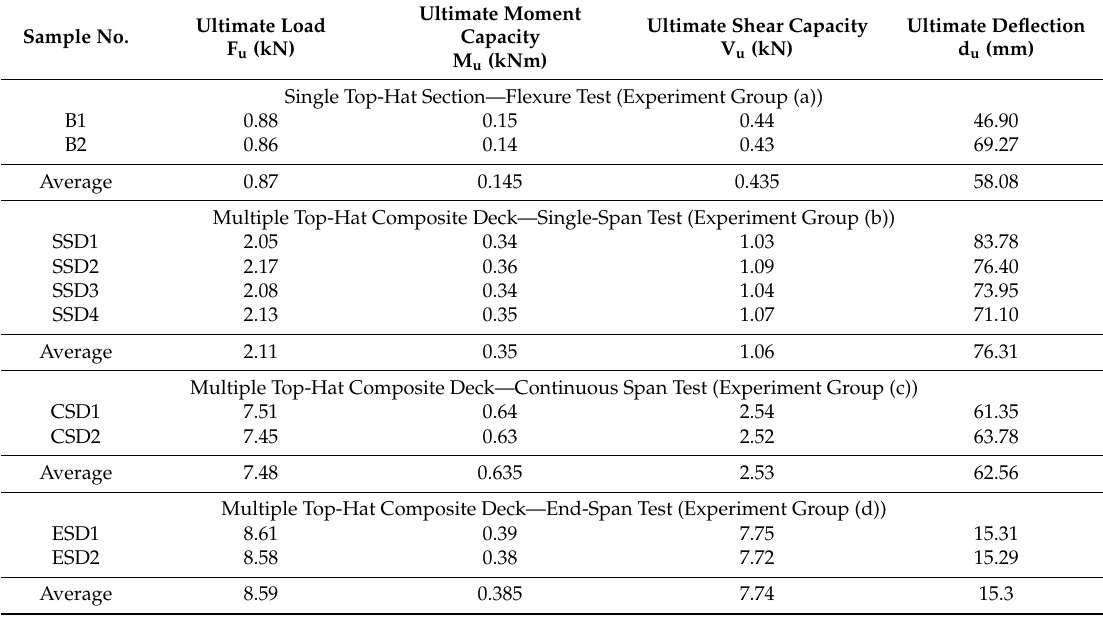
Table 2. Summary of test results.